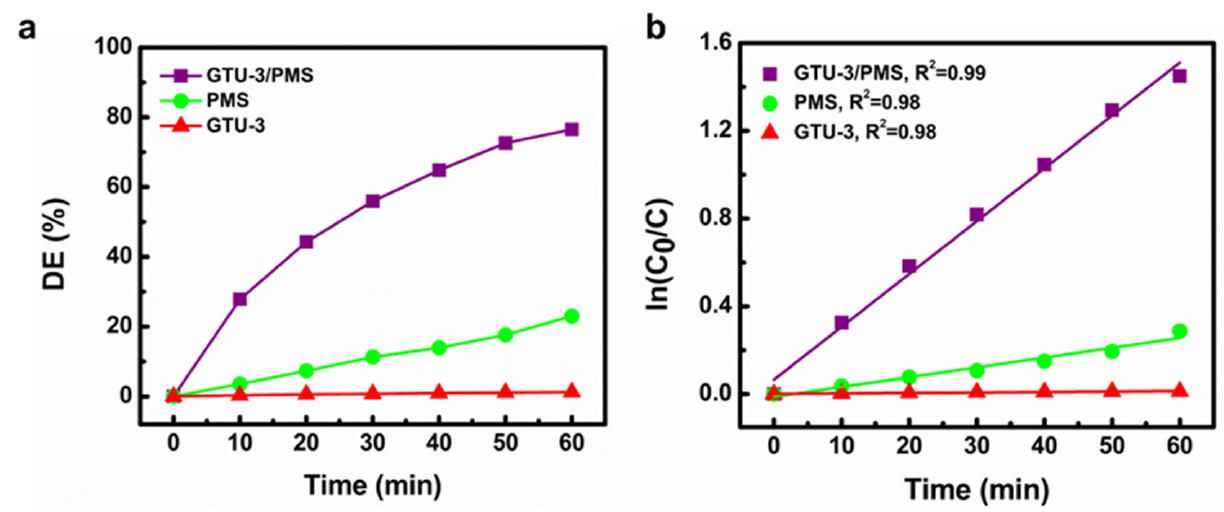
Figure 6. ( a ) Catalytic degradation efficiency of GTU-3 at different conditions, [RhB] 0 = 10 mg/L (50 mL), [PMS] = 0.5 mM, GTU-3 = 0.4 g/L, and ( b ) pseudo-first-order kinetic model graph for the pro- cesses in plot a.